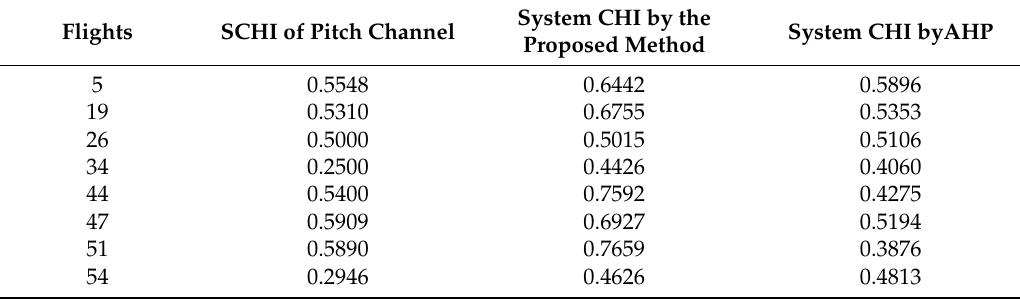
Table 7. Pitch channel’s SCHI of the flights in functional